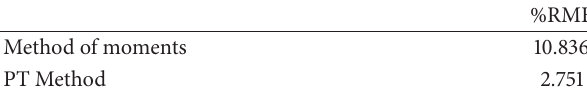
Table 2: Forecast